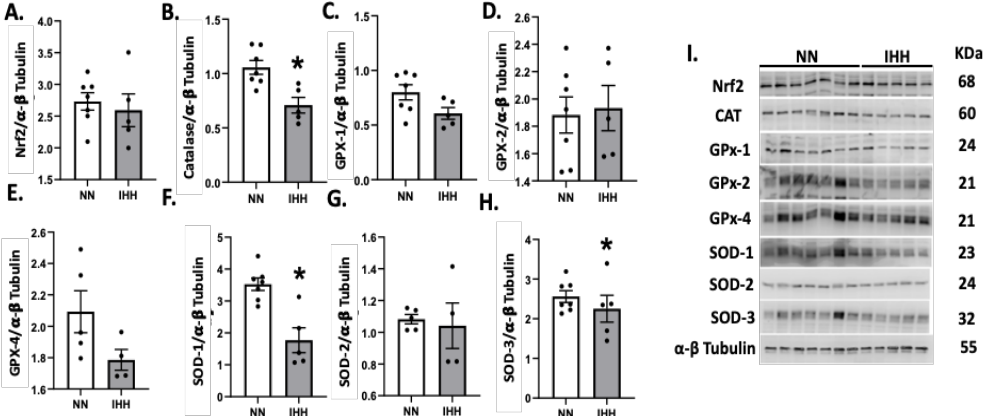
Figure 5. Cardiac levels of antioxidant-related proteins. The cardiac protein levels of Nrf2 ( A ) and the antioxidants enzymes, Catalase (CAT, ( B )), Glutathione peroxidase-1 (GPX-1, ( C )), Glutathione peroxidase-2 (GPX-2, ( D )), Glutathione peroxidase-4 (GPX-4, ( E )), and Superoxide Dismutase (SOD-1, 2, and 3 ( F – H )). ( I ), corresponds to blot bands and standard weight. Groups are normobaric normoxia (NN, n = 6) and intermittent hypobaric hypoxia (IHH, n = 6). Data are expressed in mean ± SEM. Significant differences ( p ≤ 0.05): * vs.